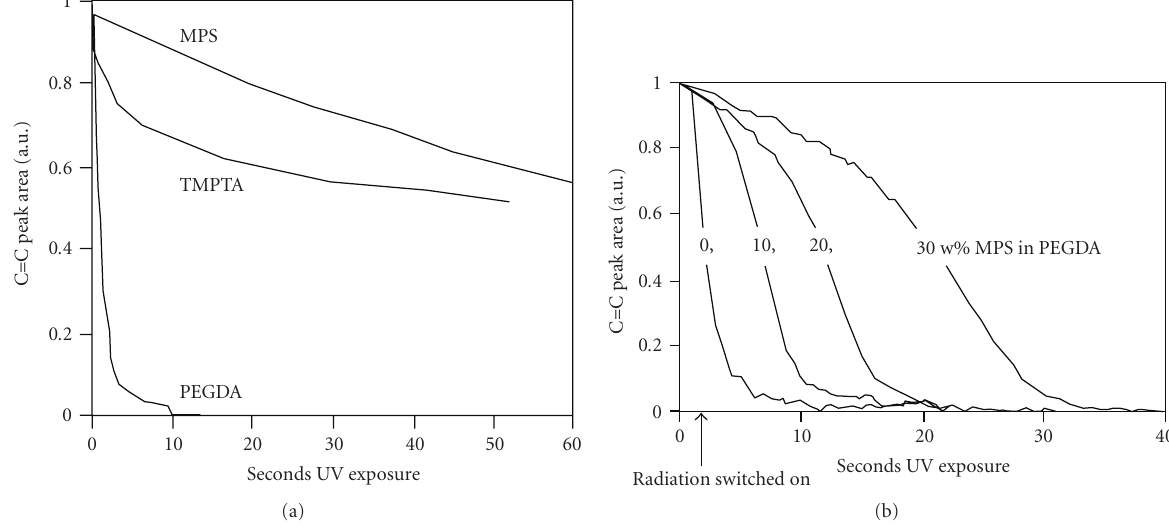
Figure 7: UV radical polymerization of MPS and PEGDA 575 monomers photocatalysed by 2-hydroxy-2-methyl propiophenone under nitrogen followed by real-time FTIR (at 1637 cm − 1 ) [28]. (a) Homopolymerizations of the (meth)acrylate monomers.; (b) copolymerizations of the (meth)acrylate